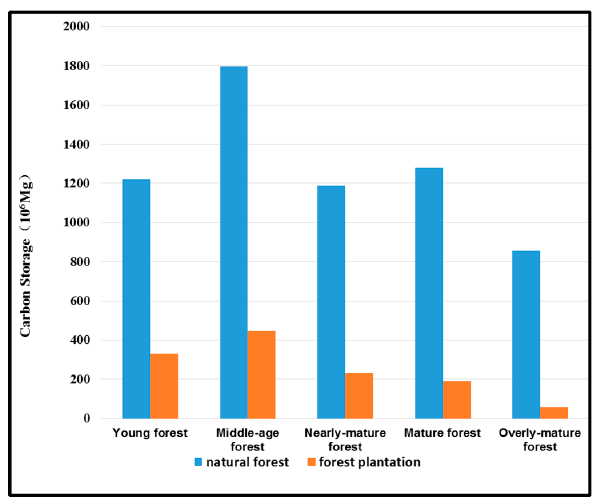
Figure 2. Carbon storage by source and age group.